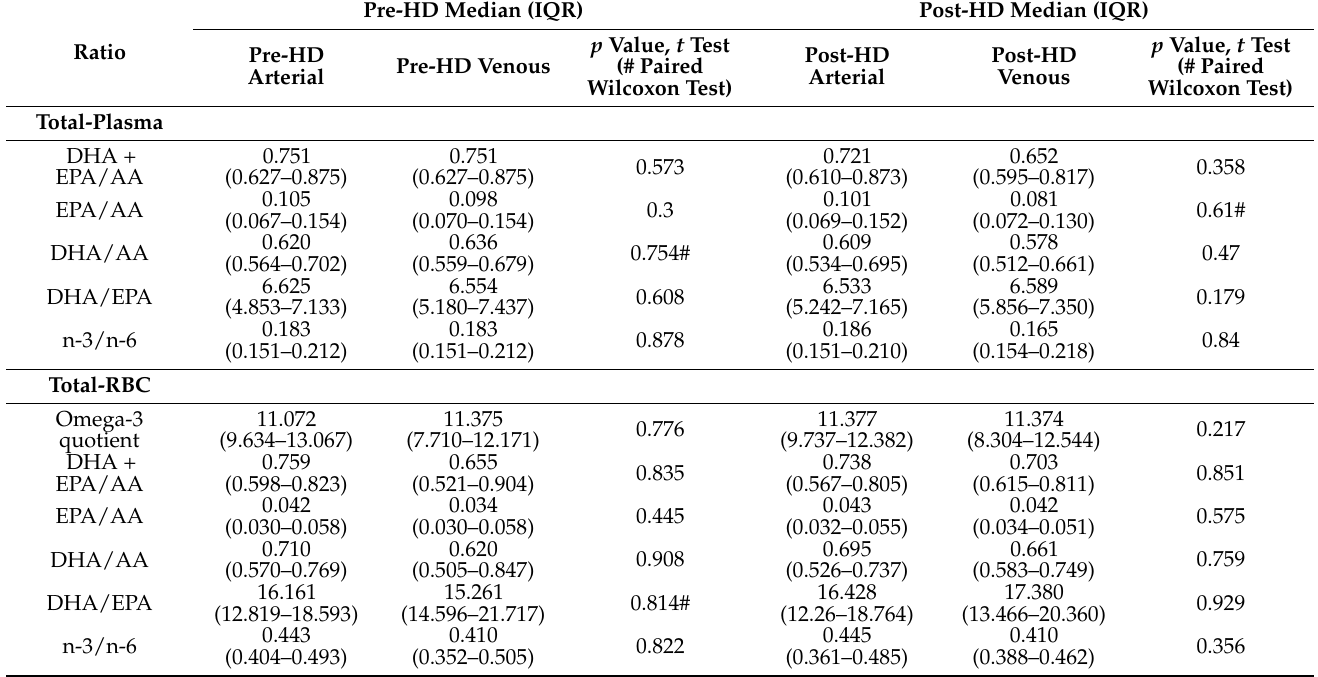
Table 4. Effect of hemodialysis on polyunsaturated fatty acid ratios in plasma and RBCs in the CKD patients before (pre-HD) and at cessation (post-HD) of hemodialysis ( n = 12 each).